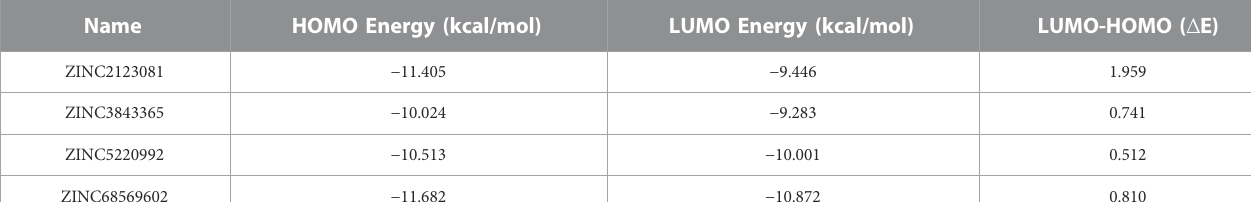
TABLE 2 Orbital energy values of lead compounds with their energy